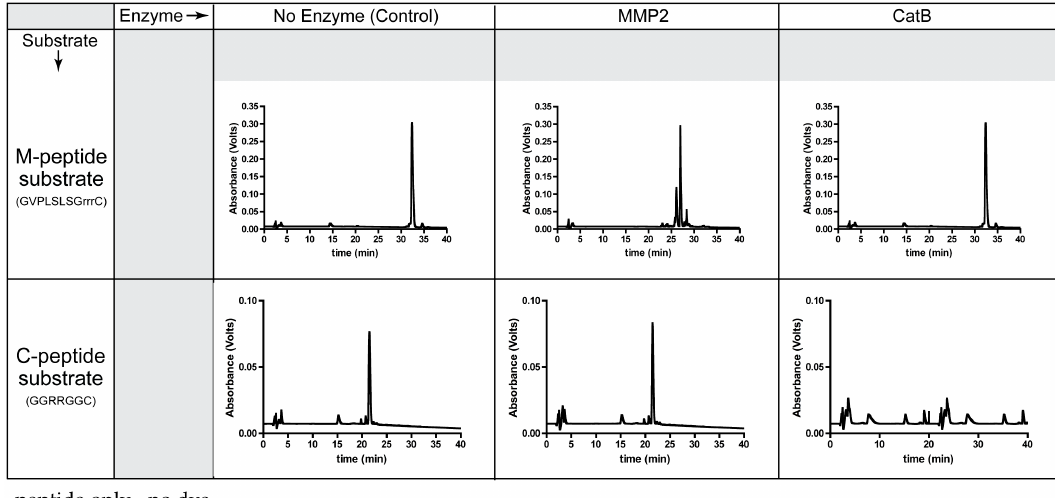
Figure 1. Specificity of each peptide substrate for its corresponding enzyme.